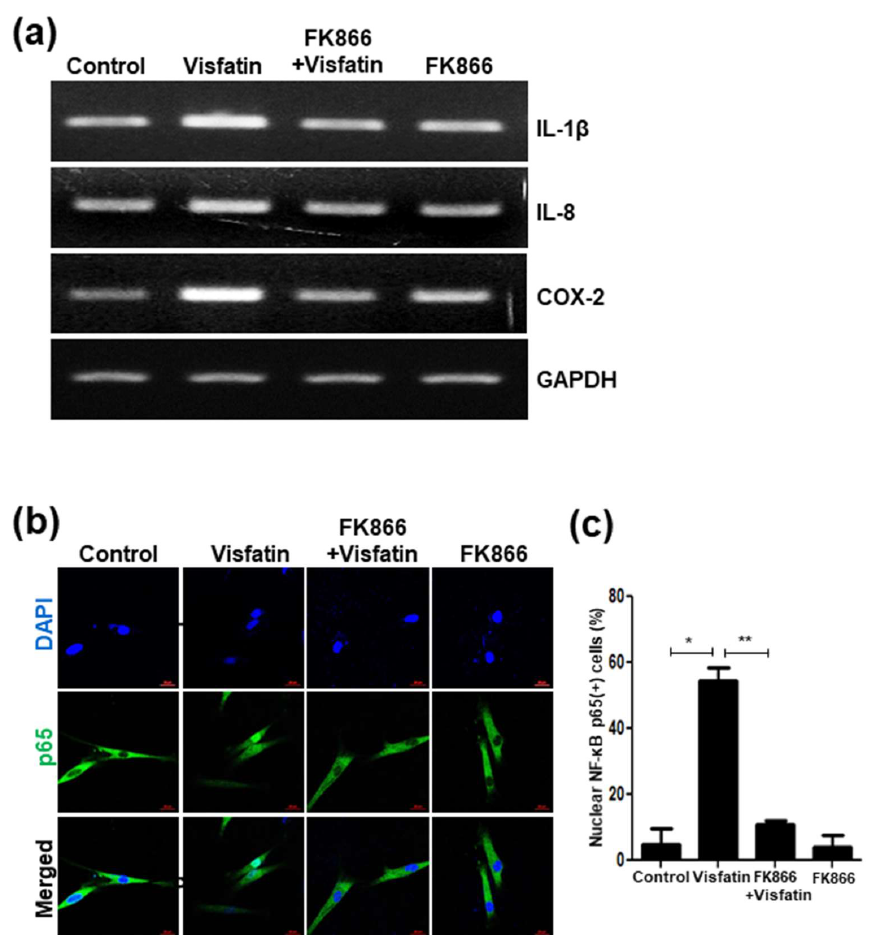
Figure 7. Increased levels of senescence-associated secretory phenotype (SASP) markers and activation of NF- κ B p65 in hDPCs after exposure to visfatin. Human dental pulp cells (hDPCs) were pretreated with FK866 (10 µ M) for 2 h and then incubated with visfatin (500 ng / mL) for 24 h. ( a ) Cell lysates were subjected to RT-PCR to determine the mRNA levels of indicated SASP markers. GAPDH was used as an internal control. ( b ) The immunocytochemical analysis of NF- κ B p65 protein localization in visfatin-treated cells. Cells were evaluated using a fluorescence microscope. Nuclei were counterstained with DAPI (blue). ( c ) Quantification of the percentage of nuclear localization of NF- κ B p65. Scale bar: 50 µ m. * p < 0.1, ** p <